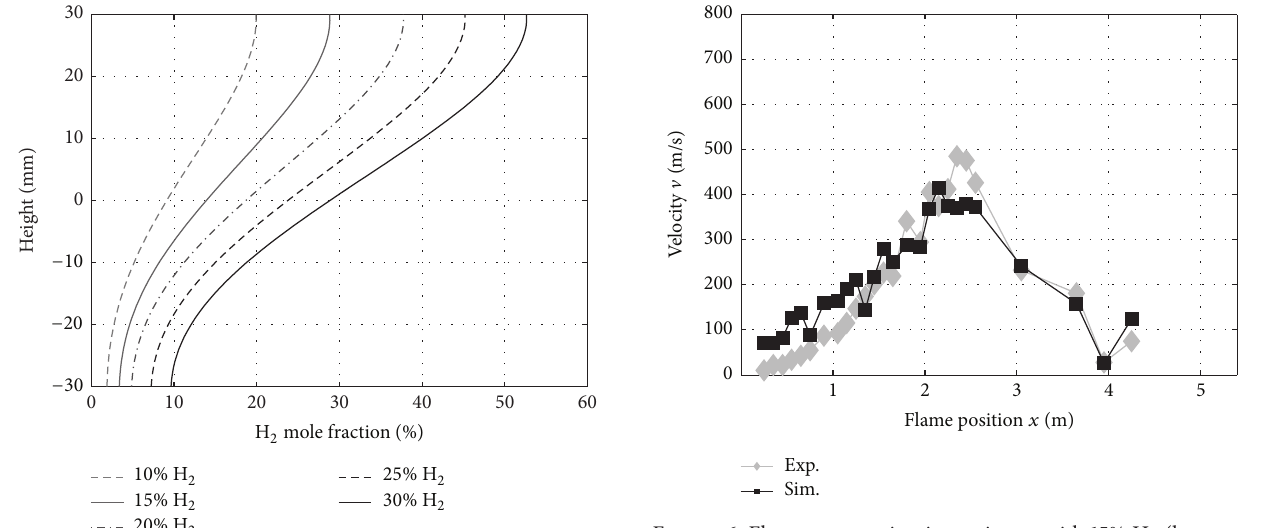
Figure 6: Flame propagation in a mixture with 15% H 2 (homoge- neous).